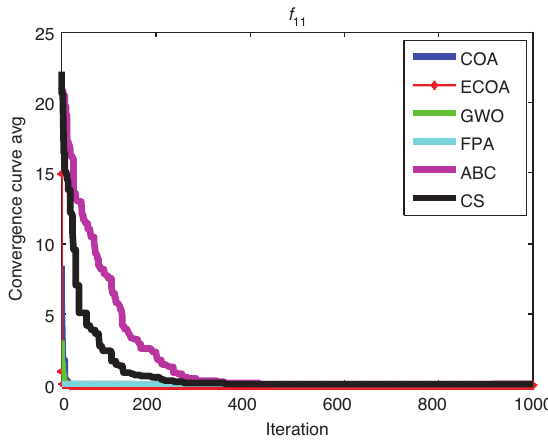
Figure 21: D = 30, Evolution Curves of Fitness Value for f